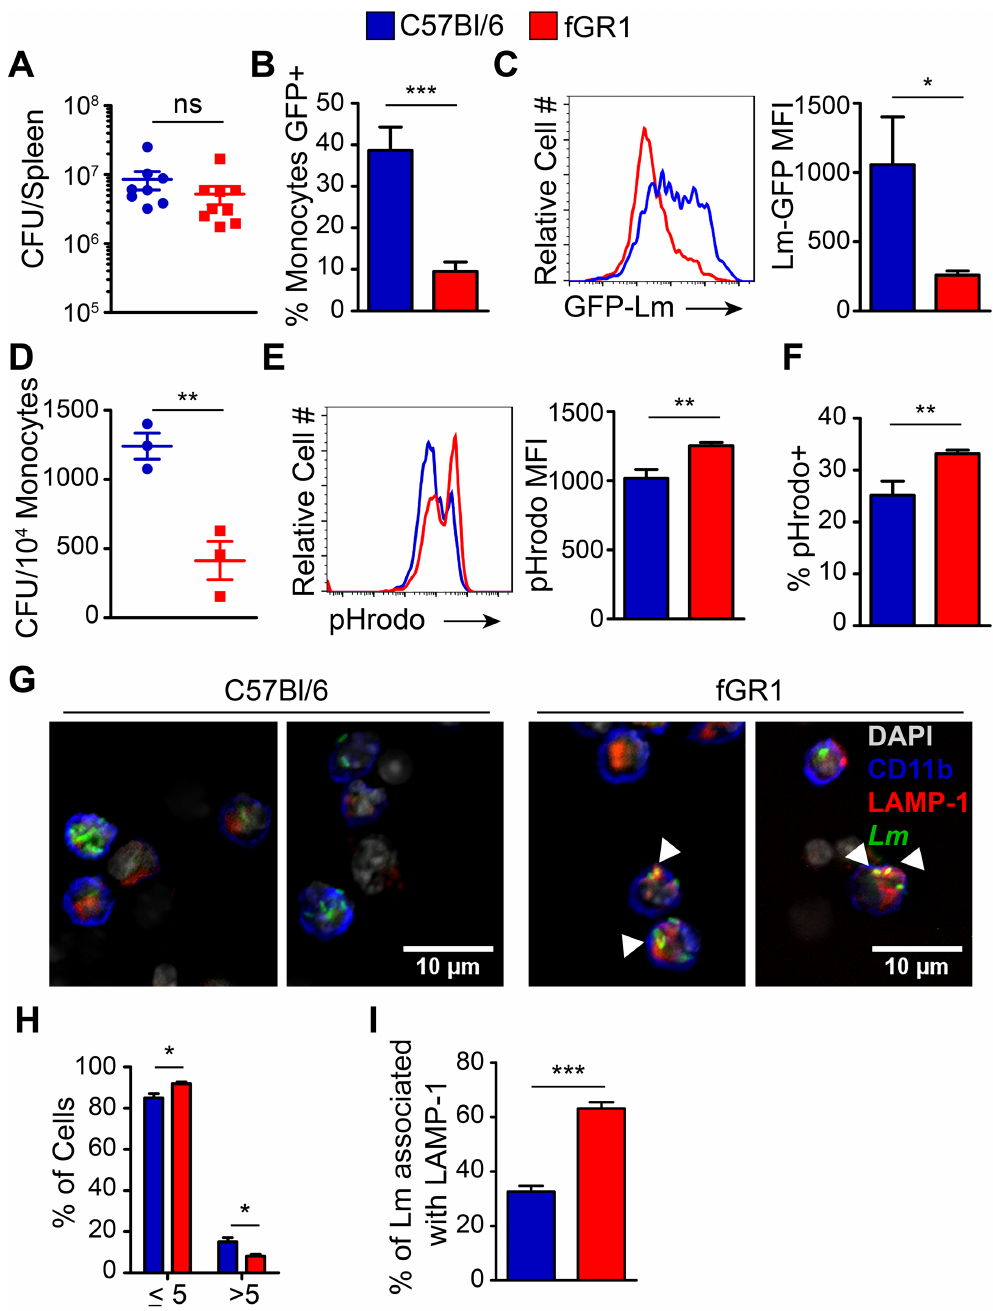
Fig 7. fGR1 expression increasesmacrophage cell intrinsic ability to kill bacteria. A). Bacterial burdensfrom C57Bl/6(blue) and fGR1 (red) mice 60 hpi. Flow cytometry was used to determinethe B) frequency of monocytes infected by GFP-expressing L . monocytogenes (Lm) 60 hpi, and C) MFI of GFP- Lm within the inflammatory monocyte population(Data pooledfrom 3 independentexperiments, 3–5 mice per group). D) Inflammatory monocytes were FACS sorted and lysed to determine Lm bacterial burdens60 hpi. (Representative CFUs from 2 independentexperiments, 3 mice per groups per experiment). pHrodo S . aureus Bioparticleswere incubatedfor 30 min with enrichedmyeloidcells isolated from 60 hpi spleen and the E) MFI and F) frequency of pHrodopositive inflammatory monocytes was determined by flow cytometry (Representative data from 2 independentexperiments, 3 mice per group per experiment). G) Spleenswere depletedof CD90.2+, IgM+, NK1.1+, Ly6G+ cells and CD11b + cells were analyzedby fluorescent microscopy. Arrows indicatecolocalization of Lm and LAMP-1.